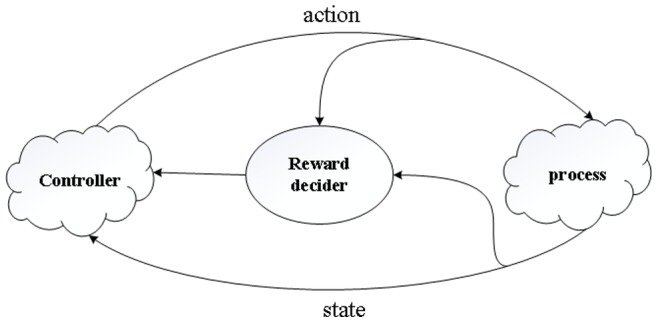
The flow of the interactions in the reinforcement learning framework.